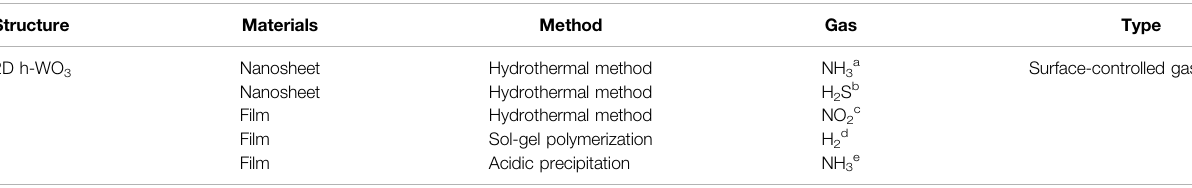
TABLE 1 | The preparation methods and types of 2D h-WO 3 .